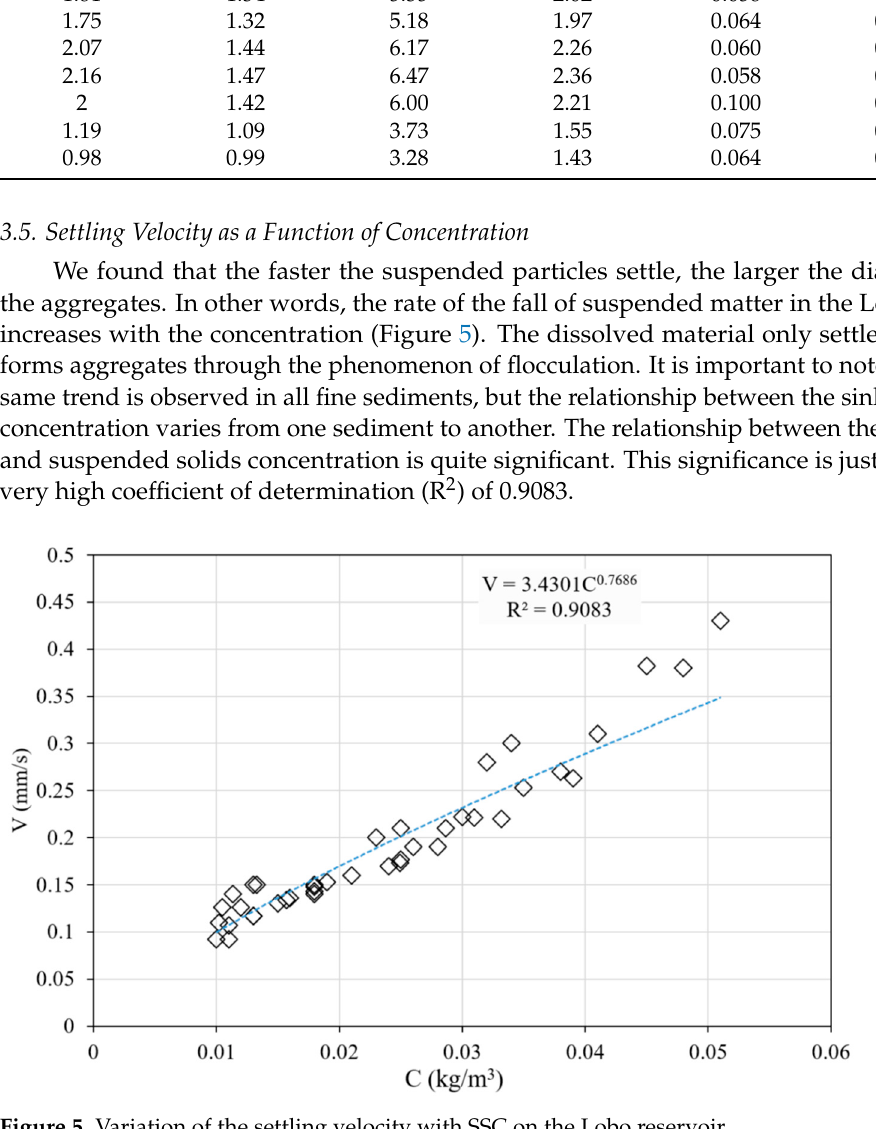
Table 4. Mean settling velocity of suspended solids as a function of the shape parameter r characteris- tic of the Lobo reservoir in 2020.